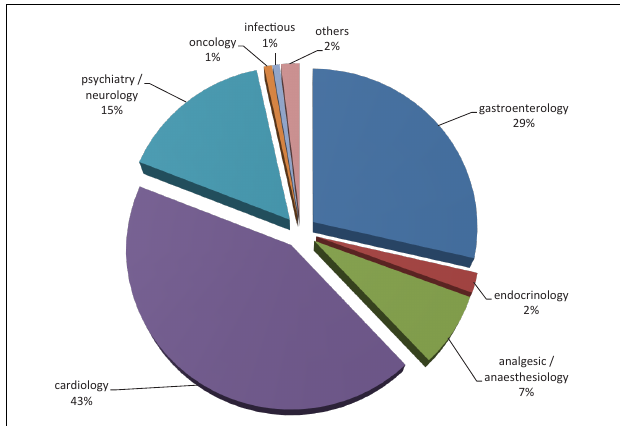
FIGURE 2 | Level of consumptions of different PGX medication